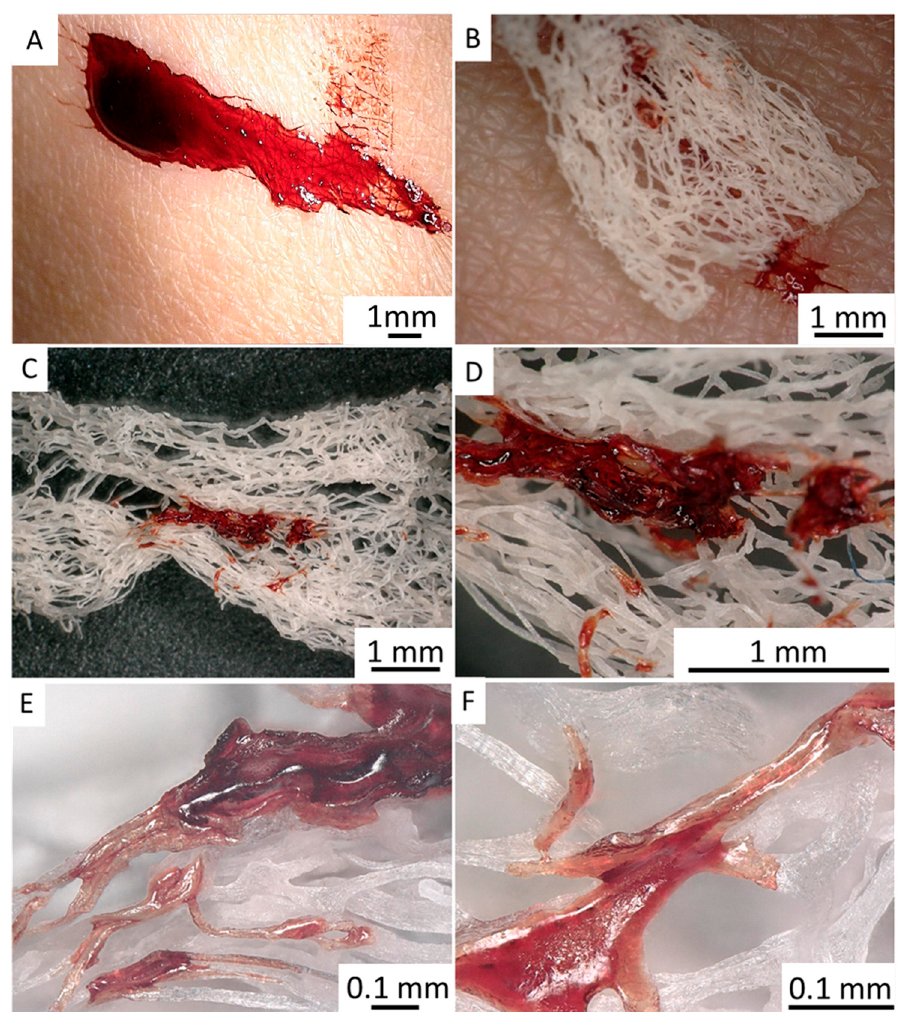
Figure 12. Chitinous scaffold isolated from I. labyrinthus can immediately absorb pig blood ( A – D ) from the skin surface. The blood is “sucked out” and located within the chitinous microtubes ( E , F ) in contrast to synthetic bandage (Figure 13), where blood is adsorbed on the surface and in the interspace of the monolithic, non-tubular microfibers. Pig blood (Südost-Fleisch GmbH, Altenburg, Germany).